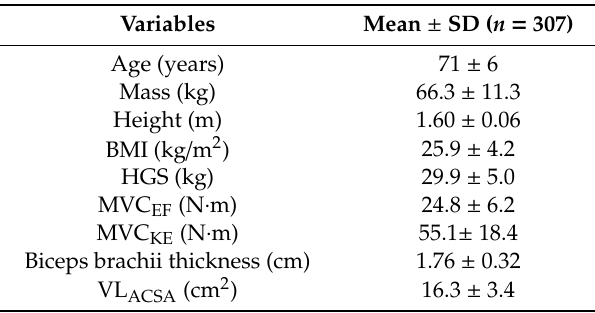
Table 1. General characteristics of the